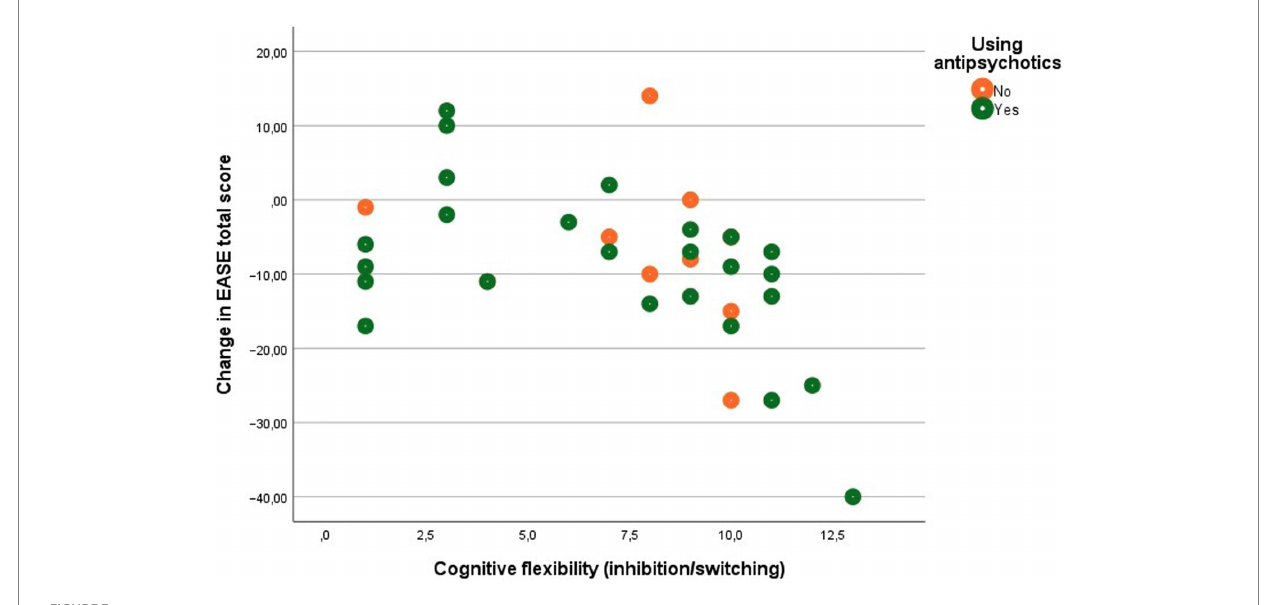
FIGURE 3 Scatter plot of associations between cognitive flexibility and SDs.